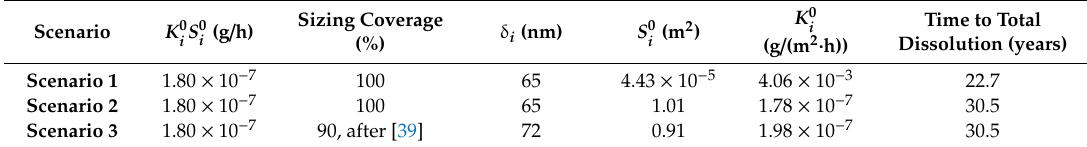
Table 4. Systematized scenarios of the interphase dissolution